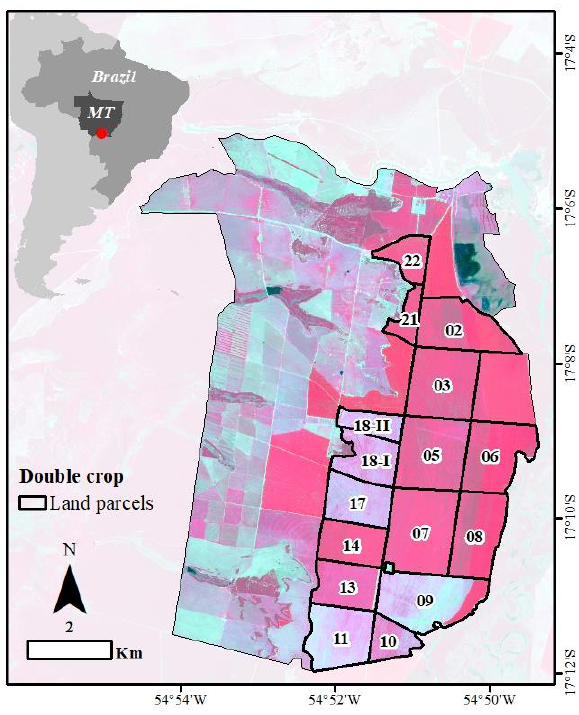
Figure 1 . The Gravataí farm and its representation in PS false colour composition (Red = near-infrared, Green = red, Blue = green) from